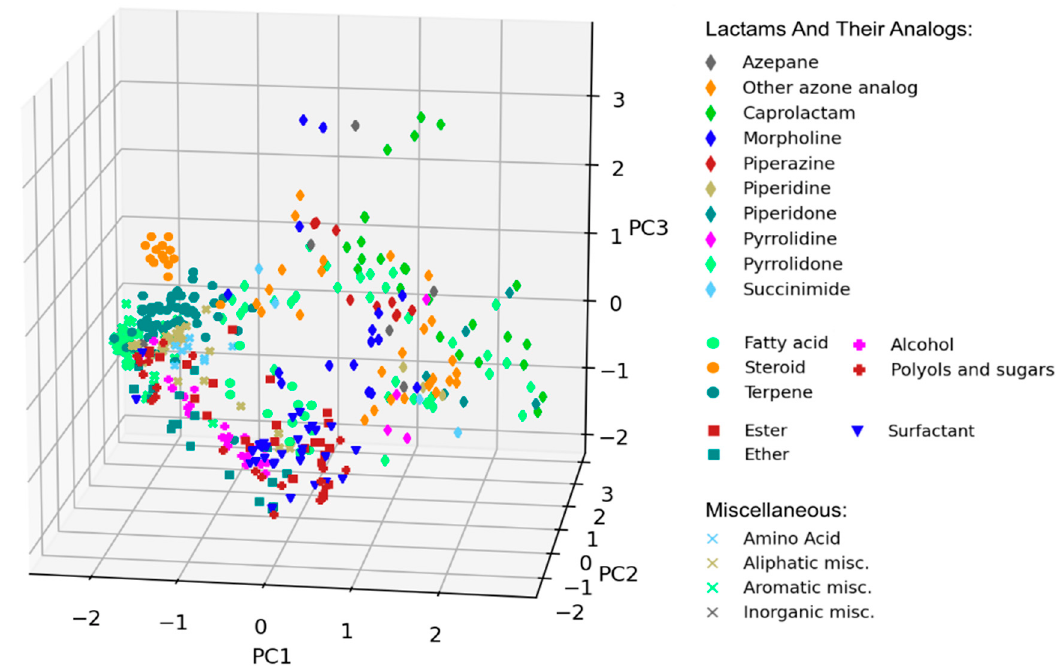
Figure 3. Visual representation of chemical diversity of chemical penetration enhancers (CPEs). Compounds were projected onto the first three principal components obtained using principal component analysis (PCA) and colored according to their CPE classes.